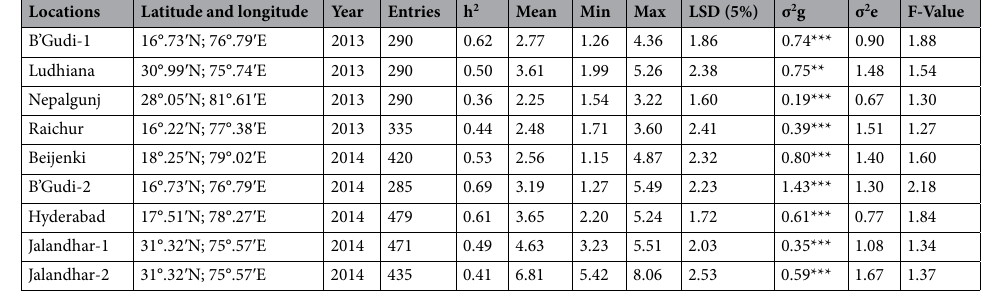
Table 1. Details of the locations and descriptive statistics for grain yield (t ha −1 ) of HTAM panel testcrosses evaluated under heat stress. h 2 broad-sense heritability, LSD least significant difference, σ 2 g genotypic variance, σ 2 e error variance. *** , ** , *Significant at p < 0.001, 0.01 and